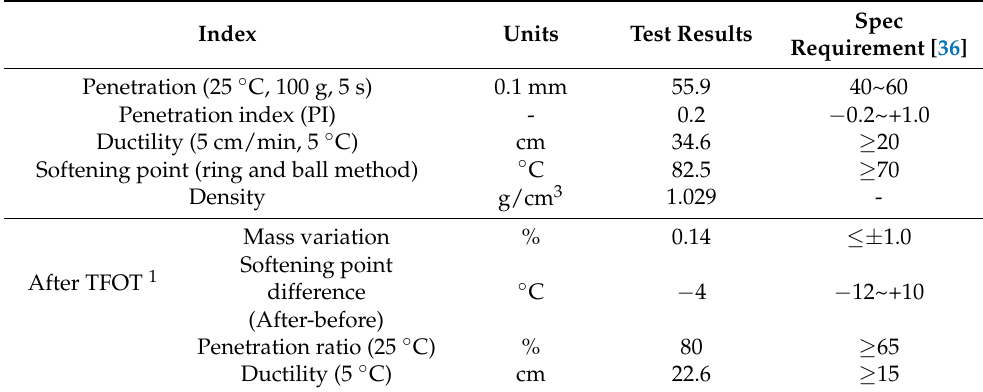
Table 1. Technical Indices of the SBS Modified